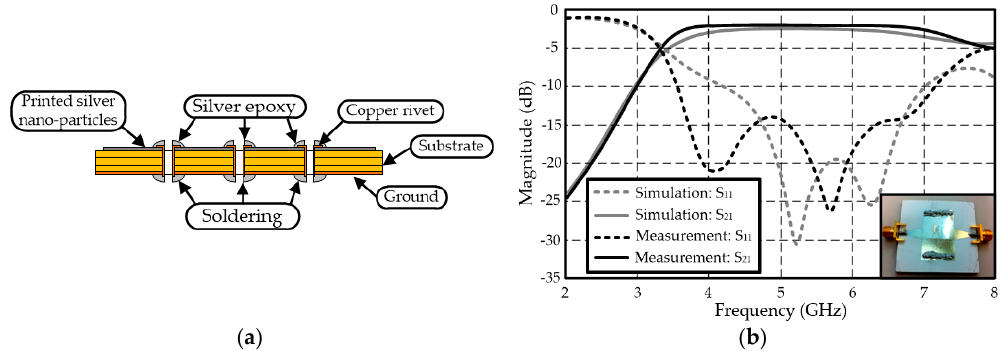
Figure 13. Inkjet-printed µStrip-to-substrate-integrated waveguide (SIW) transition: ( a ) via fabrication on a paper substrate, and ( b ) the frequency response of the component.